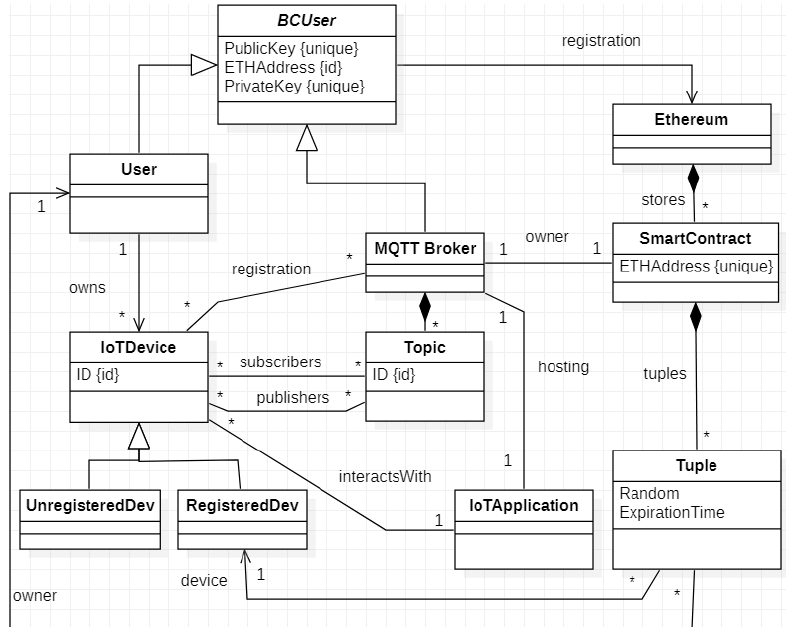
Figure 3. Domain model of our